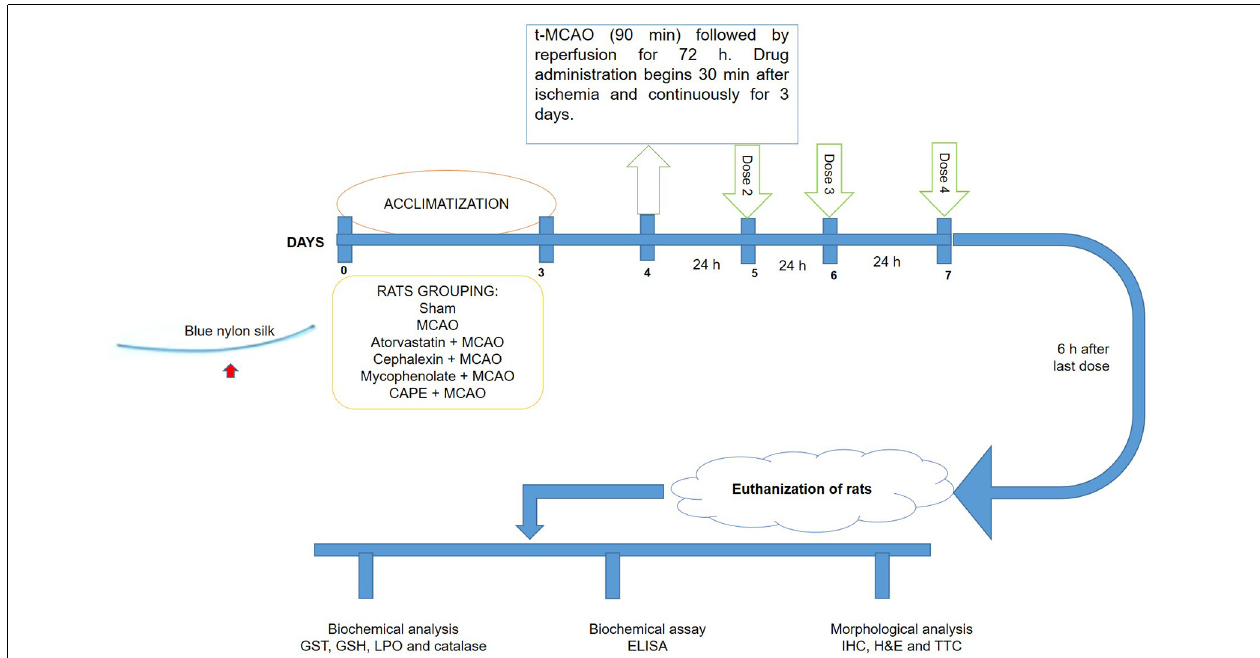
FIGURE 1 | Schematic presentation of experiment: rats acclimatization, middle cerebral artery occlusion (MCAO) surgery, drug administration, neurobehavioral studies, euthanization of rats for tissue collection to carry out biochemical analysis, i.e., glutathione-S-transferase (GST), glutathione (GSH), catalase and lipid peroxidation (LPO), morphological analysis (2,3,4-triphenyl tetrazolium chloride staining, hematoxylin and eosin staining, and immunohistochemistry), and biochemical assay (enzyme-linked immunosorbent assay ELISA). The red arrow indicates the blue nylon silk (3/0) approximately 3 cm in length with a bulging